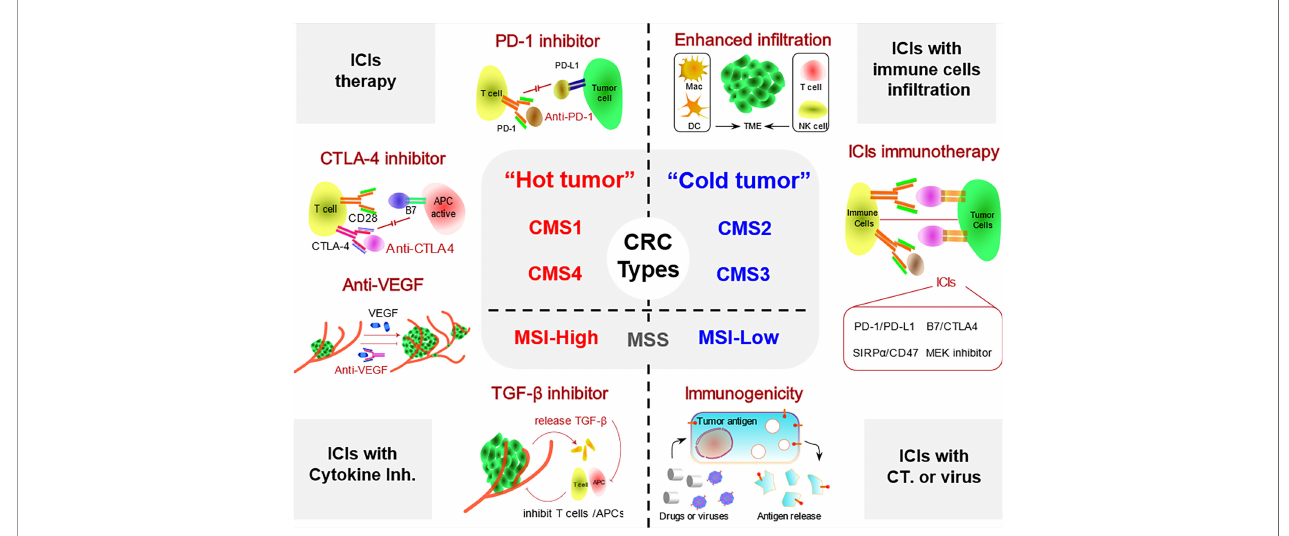
FIGURE 1 | Different types of ICI-based immunotherapy strategies for patients with CRC. CRC is divided into hot and cold tumor subtypes. Hot CRC mainly includes the dMMR/MSI-H, CMS1, and CMS4 subtypes, while cold CRC includes the pMMR/MSI-L, CMS2, and CMS3 subtypes. TME, tumor microenvironment; Inh., inhibitor; CT, chemotherapy; ICI, immune checkpoint inhibitor; CRC, colorectal cancer; dMMR, de fi cient DNA mismatch repair; MSI-H, high microsatellite instability; pMMR, pro fi cient mismatch